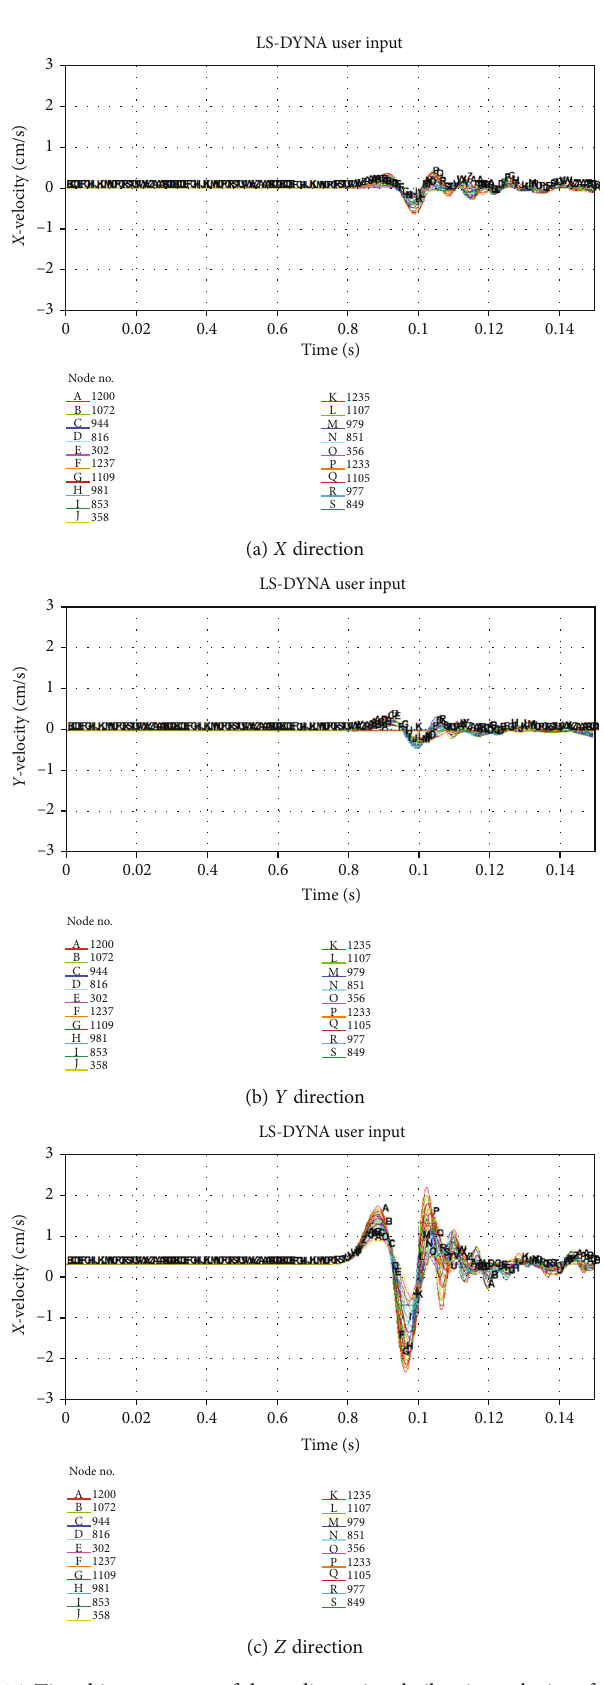
Figure 16: Time history curves of three-dimensional vibration velocity of